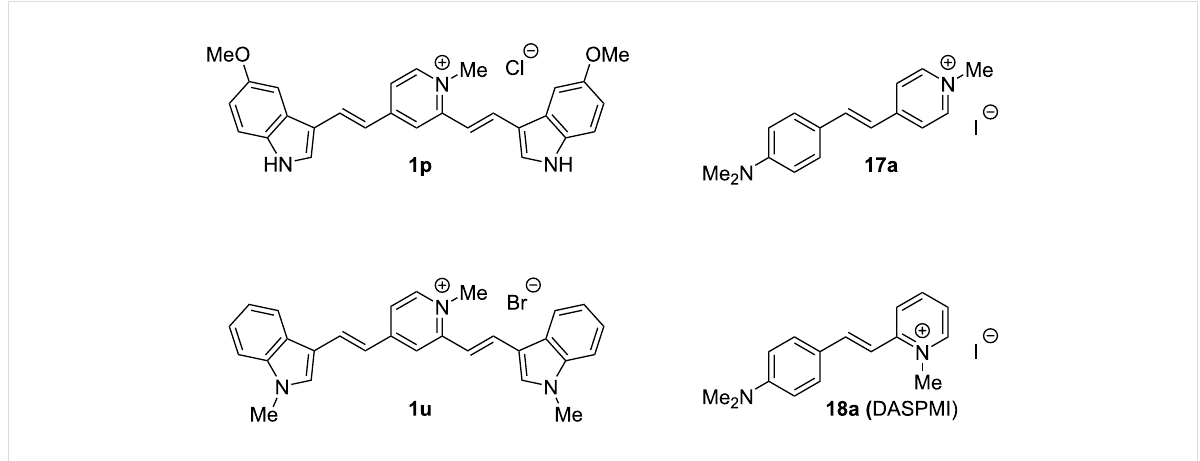
Figure 9: Selected probes featuring high fluorimetric response towards G4 structures.